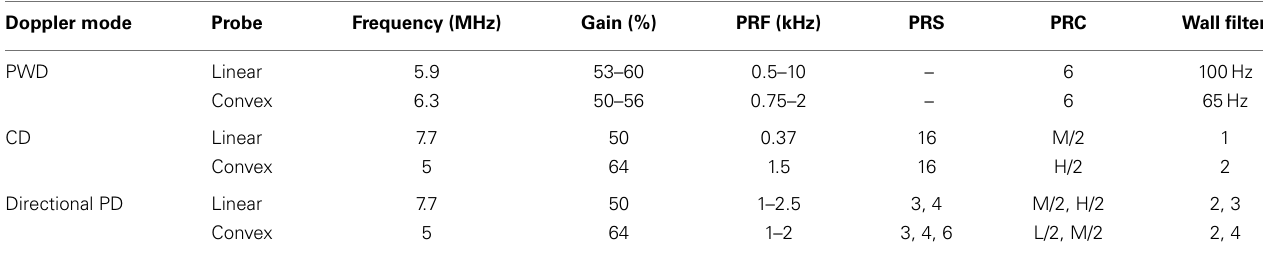
Table 1 | Ultrasound settings used in this study